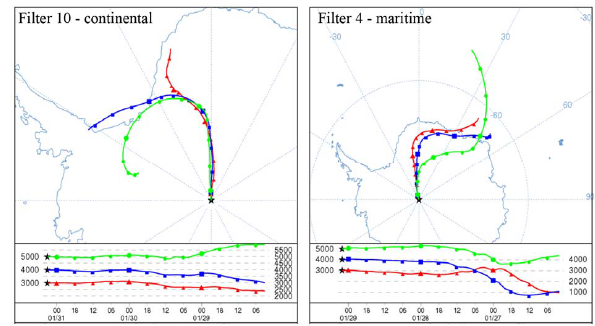
Fig. 8: Two examples of back trajectories of continental air collected on filter 10 and maritime air that was sampled on filter 4. The maps show the trajectory that the air parcels travel before reaching the station, located at an altitude of about 3000m ASL. The vertical projection for air arriving from 3000, 4000 and 5000 m is shown. Source: http://www.arl.noaa.gov.